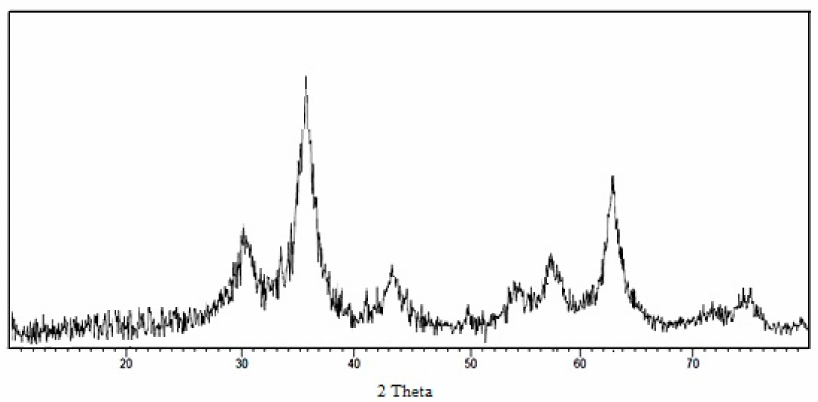
Figure 2. X-ray diffraction pattern of biosynthesized IONPs using Rosmarinus officinalis.